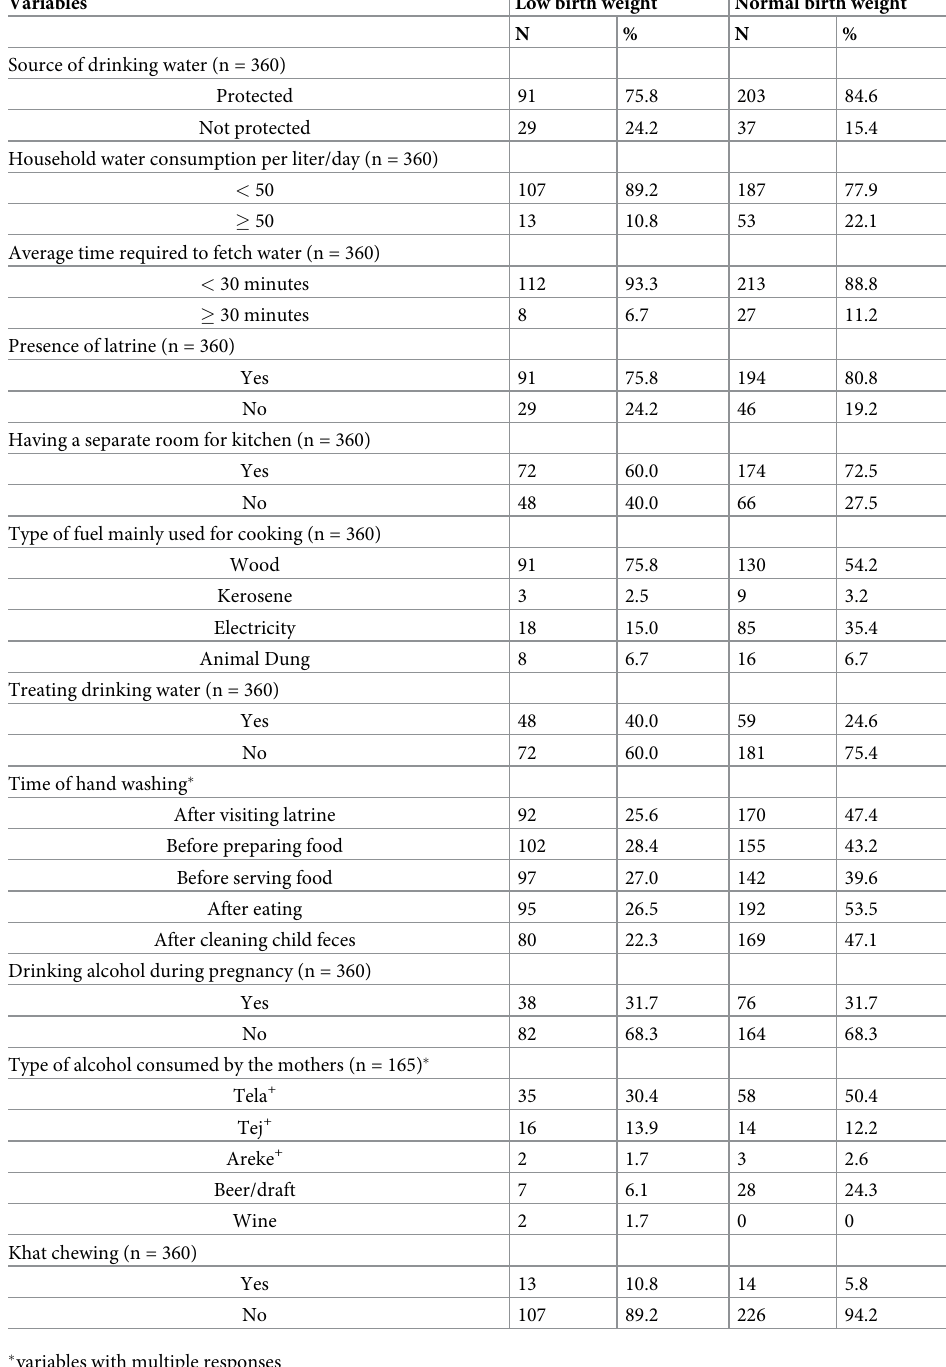
Table 3. Environmental and lifestyle characteristics of respondents in North Wello Zone Hospitals, Ethiopia, December